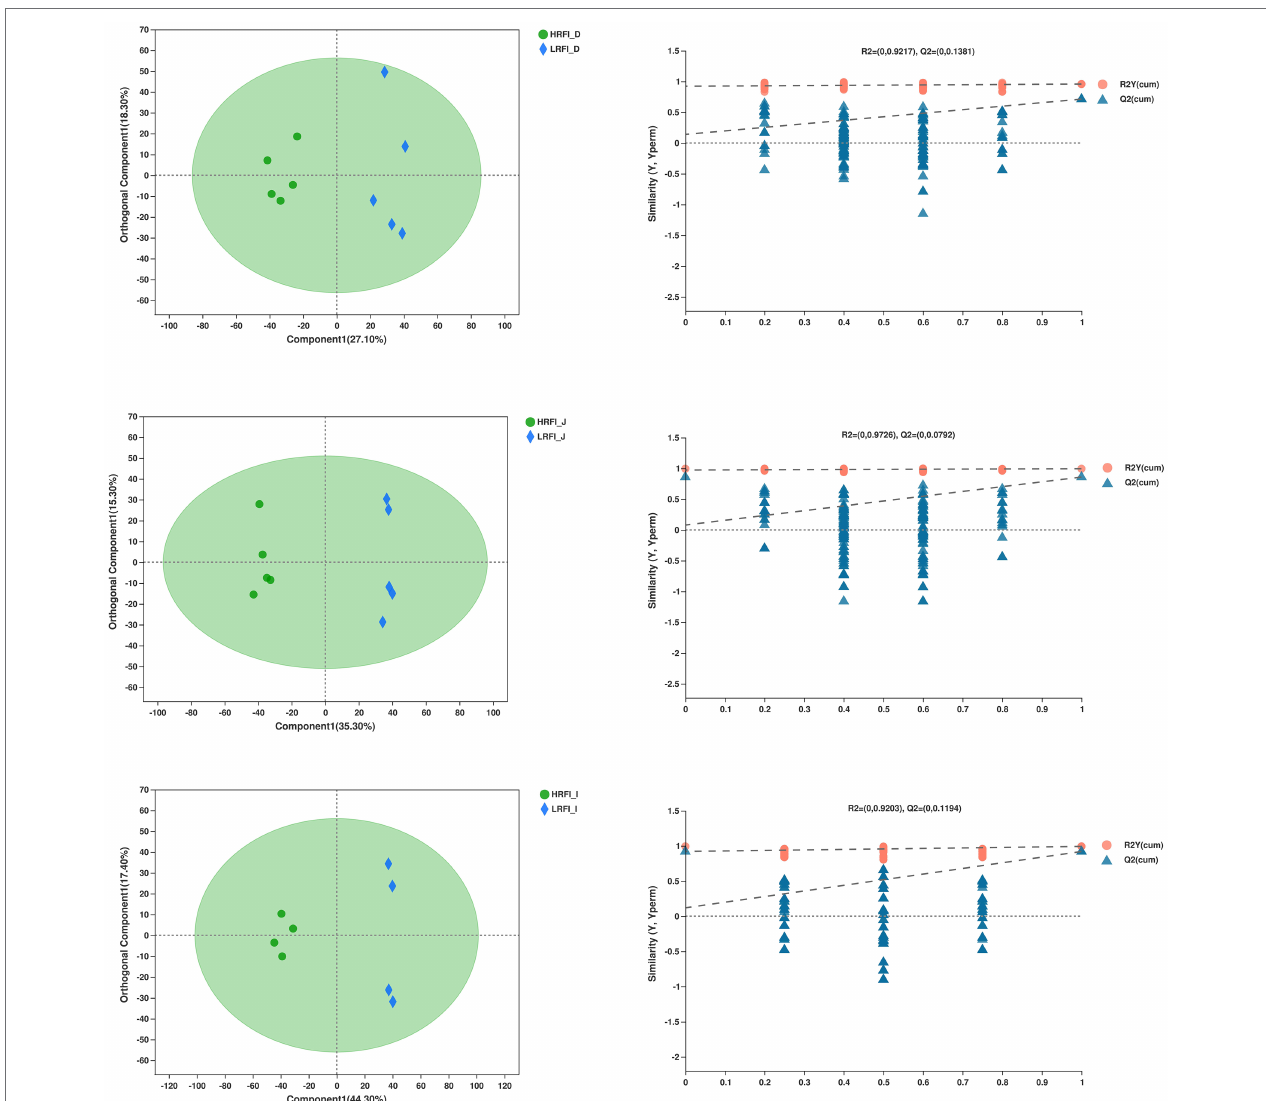
FIGURE 8 | Orthogonal partial least squares discriminant analysis (OPLS-DA) plot of the duodenum, jejunum, ileum bacterial